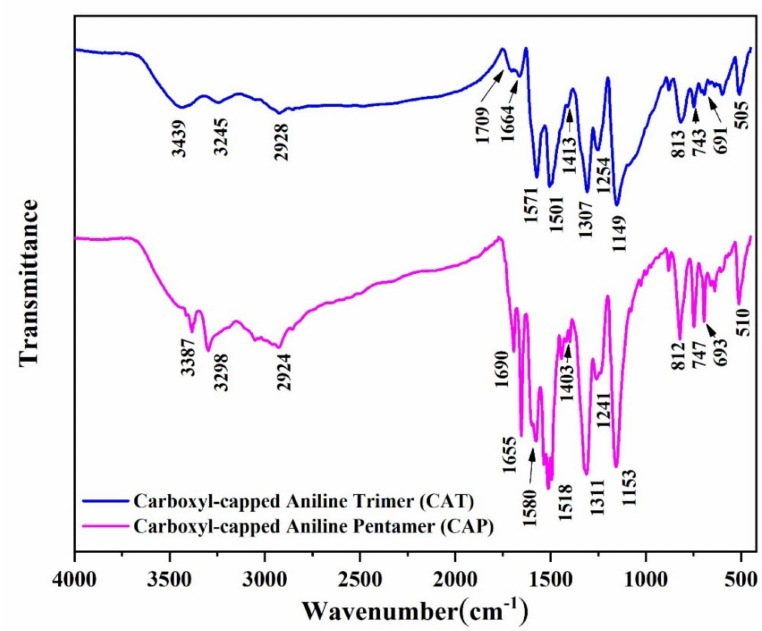
Figure 1. FTIR spectra of the synthesized aniline oligomers (CAT and CAP).